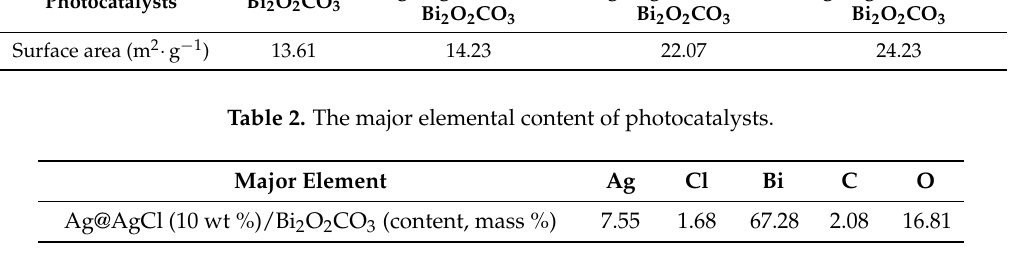
Table 1. Specific surface area of Ag@AgCl/Bi 2 WO 6 composite catalysts.